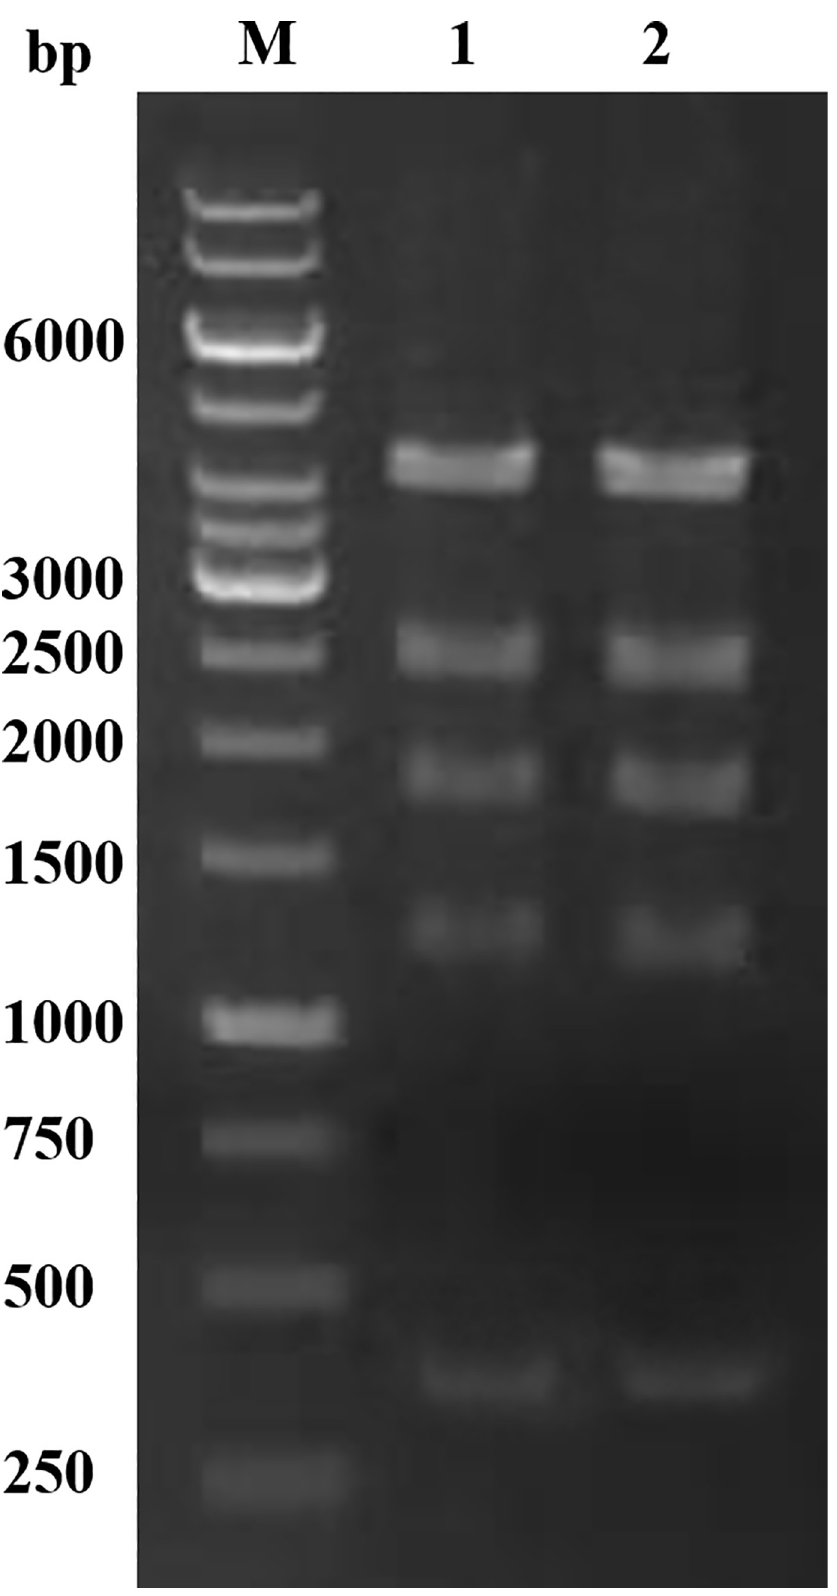
Fig 3. Characterization of the expression vector pPIC9K-HypZn with Pst